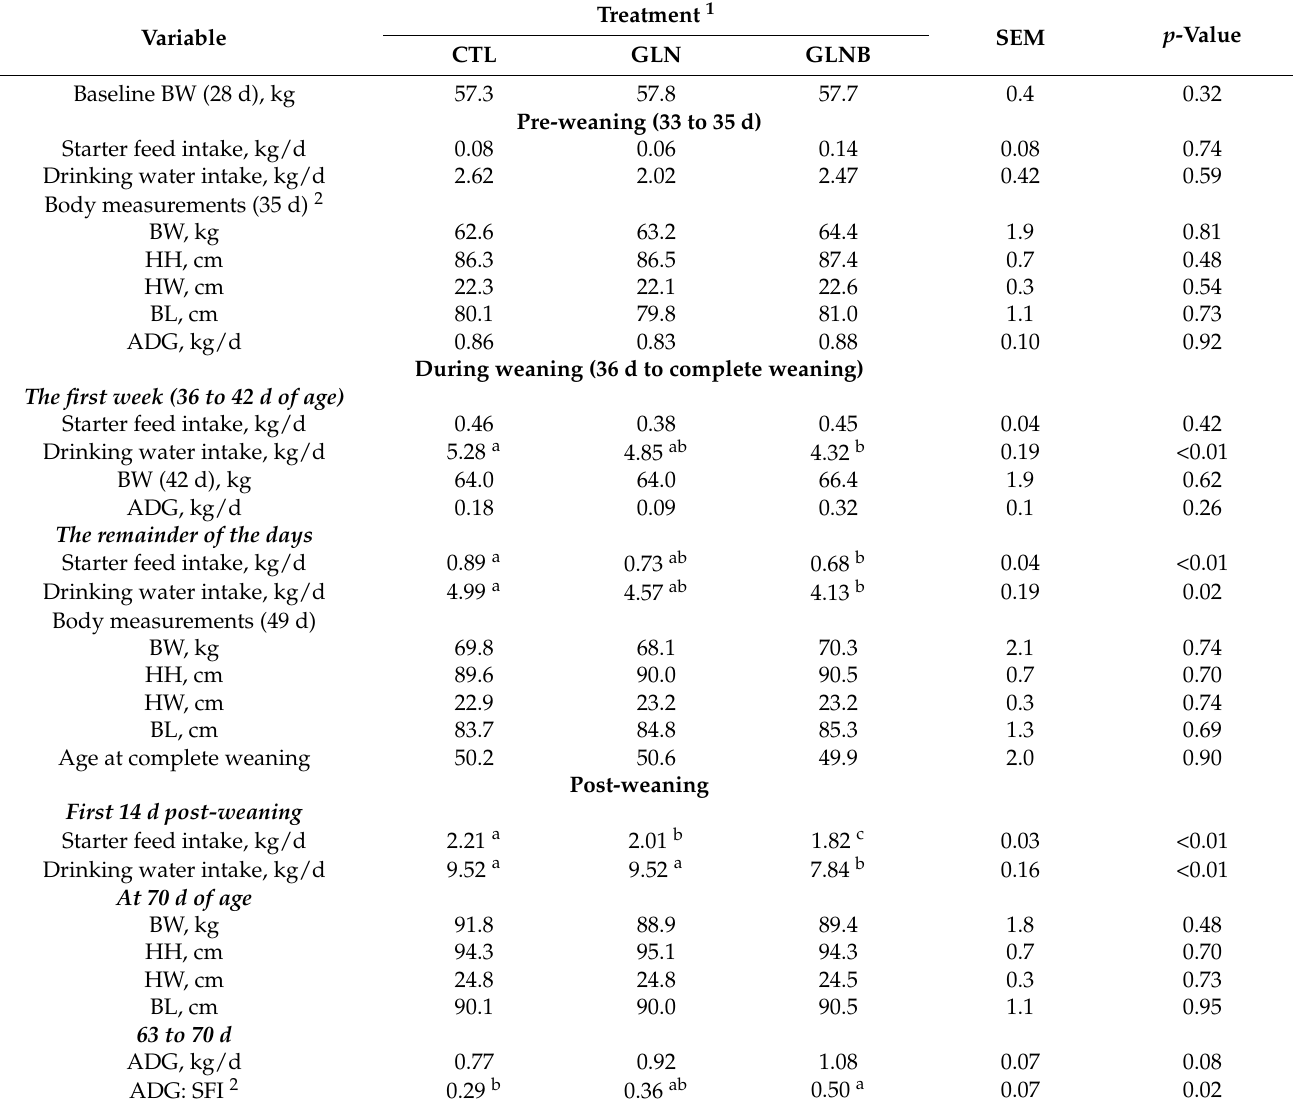
Table 1. Performance of dairy heifer calves undergoing a stepdown weaning scheme with AA supplementations ( n =